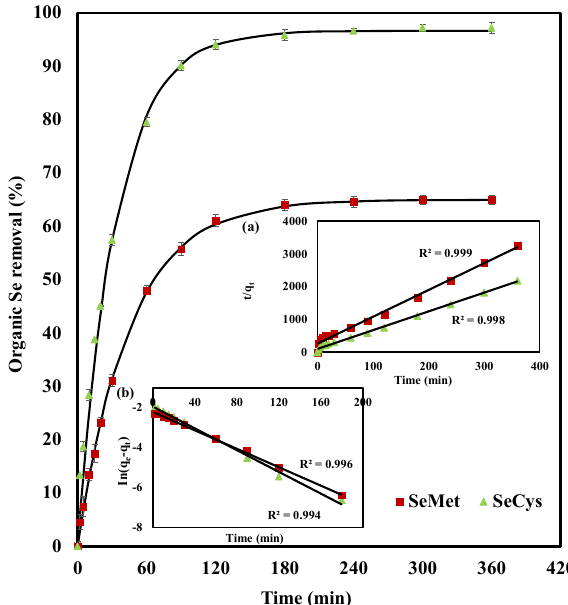
Figure 9. Organic selenium adsorption kinetics onto nZVI/GAC: ( a ) PSO and ( b ) PFO. Initial concentration 0.5 mg/L, 3 g/L, pH 7.0. (The solid lines illustrate model fits; inset shows linearization fits.)